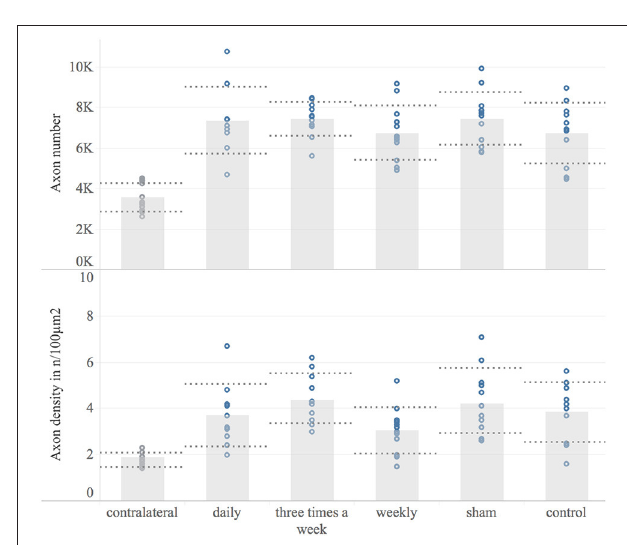
FIGURE 7 | Histological examination. This Figure shows the histomorphological data 8 weeks post-surgery for each experimental group and the contralateral reference. Displayed are bar graphs of the mean myelinated axon number (Upper) and the axon distribution density in axons/100 µ m 2 (Lower) with standard deviation (dashed lines) and combined with scatter plots of the measured data (dots). Microscopic analyzes were conducted on a constant level 6–8mm distal to the nerve suture